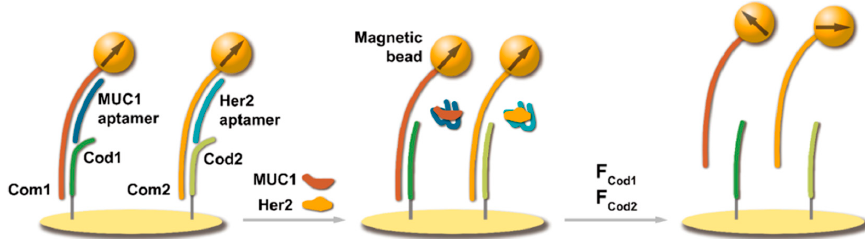
Figure 2. Simultaneous detection of multiplex proteins with magnetic field. Magnetic particles are immobilized on the substrate through DNA hybridization, as shown in the left figure. When target proteins are added, the aptamer interacts with the protein and dissociates, enhancing DNA hybridization between Com and Cod (middle figure). Stronger magnetic forces are required to dissociate magnetic particles from the substrate (right figure). The number of dissociated magnetic particles depends on the concentration of the target protein, allowing detection of multiplex proteins. Reproduced from Ref. [53] with permission. Copyright 2022 American Chemical